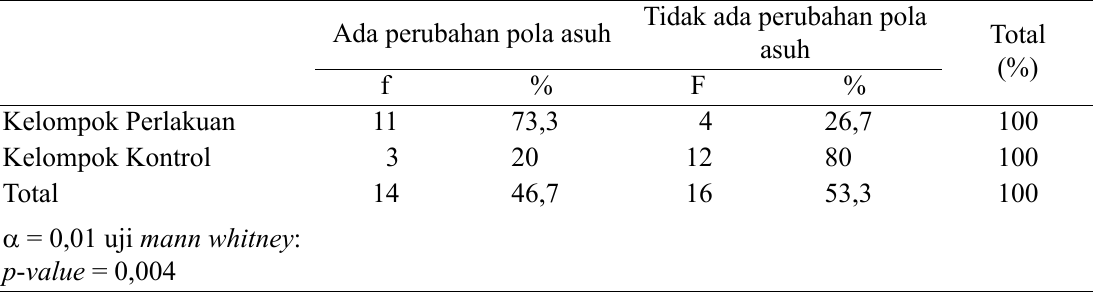
Tabel 3. Tabulasi Silang Perubahan pola asuh orang tua dalam memberikan stimulasi